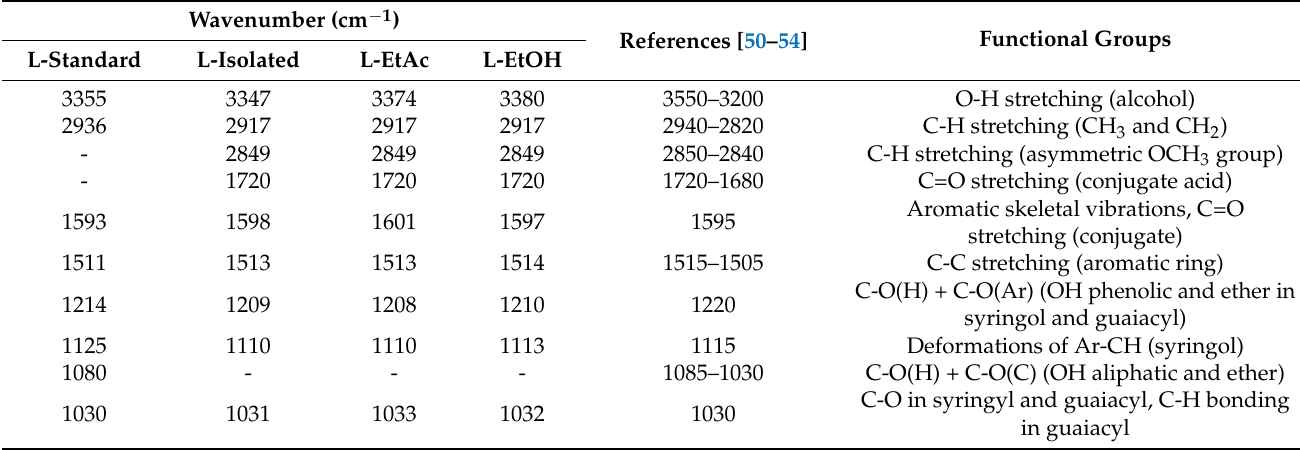
Figure 1. FTIR spectra of lignin and fractionated lignin. Table 3. FTIR band assignment of isolated and fractionated lignin.